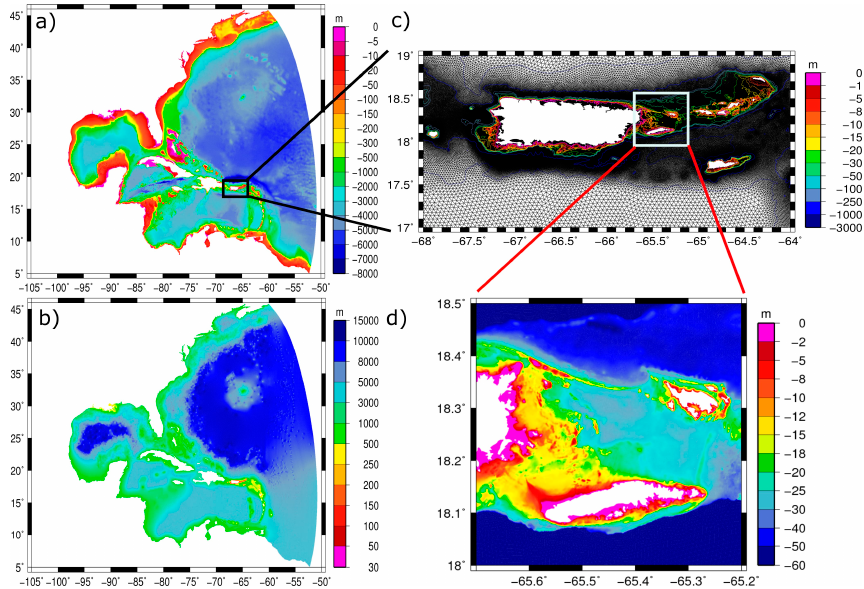
Figure 6. ( a ) Bathymetry of the full domain unstructured mesh used for the ADCIRC + SWAN simulation ( b ) spatial horizontal resolution of the unstructured mesh ( c ) detail of mesh triangulation and isobaths over the Puerto Rico and Virgin Islands region and ( d ) detail of bathymetry on the east coast of Puerto Rico, where Hurricane Georges had the most significant impact. The highest elevation is represented with the magenta tonality and the lowest elevation is represented with the blue tonality. The islands and territories are represented with the white color.